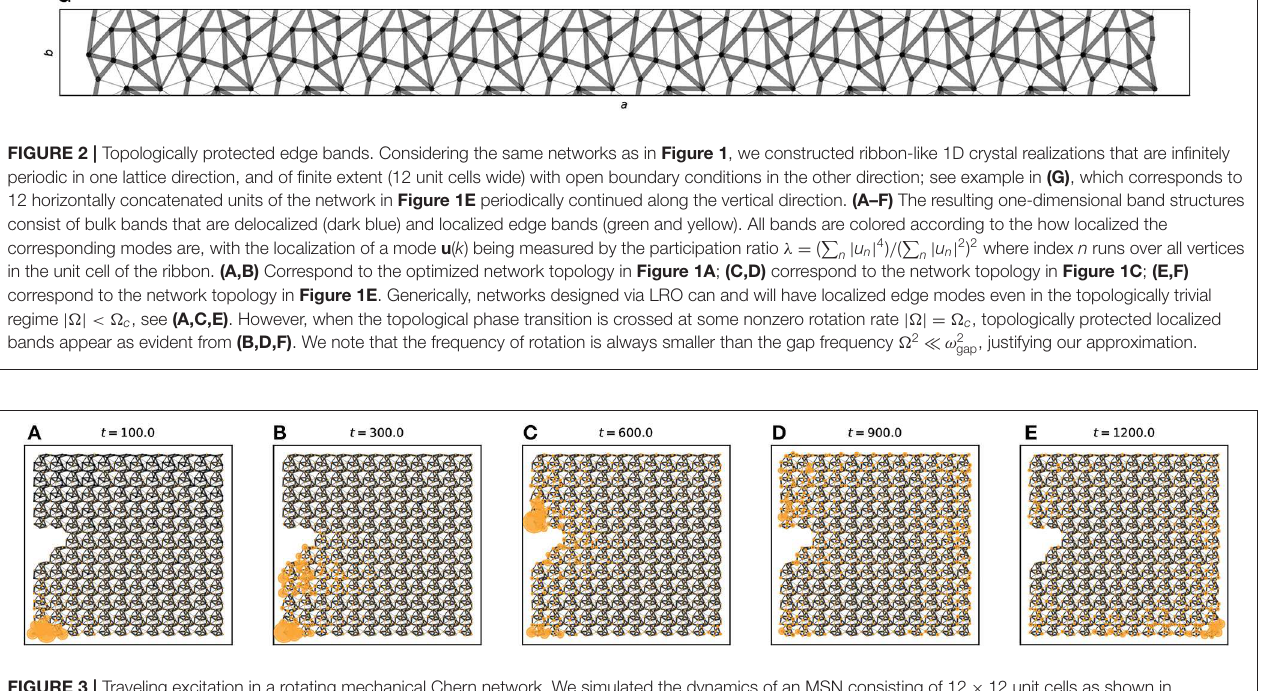
FIGURE 3 | Traveling excitation in a rotating mechanical Chern network. We simulated the dynamics of an MSN consisting of 12 Figure 1C and analyzed in Figures 2C,D . To create an edge defect, a number of unit cells was removed from the left boundary. Simulations of Equation (11) were performed in the topological regime with (cid:127) 0.15; see also Supplemental Video 1 . (A) Between t = harmonically forced with a frequency ω 0.71 in the bulk gap; see Figure 2D . (B–E) Starting at t = mechanical Chern insulator, moving over a local perturbation of the